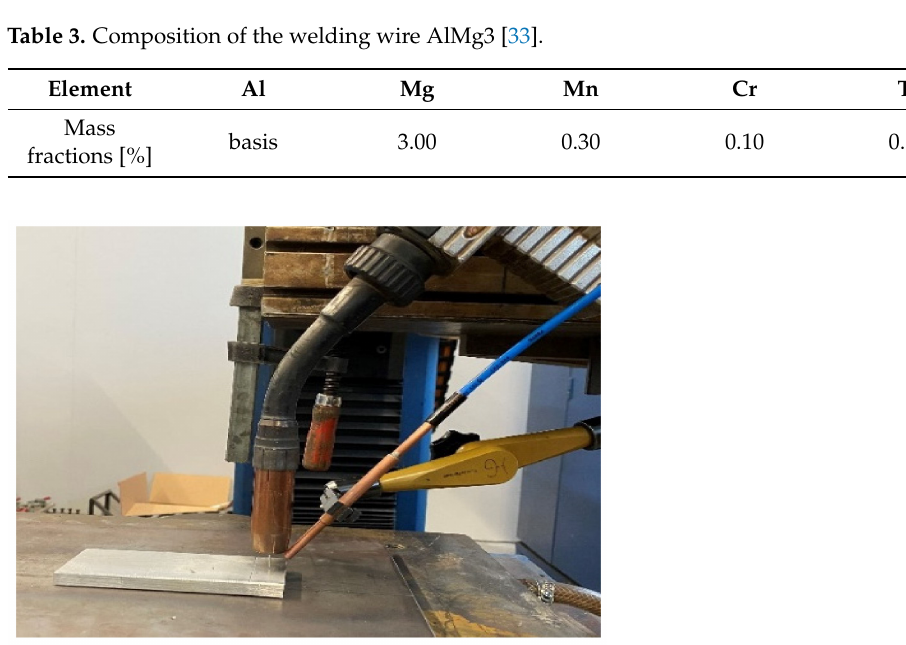
Figure 5. Process setup for the admixture of the magnetic powders in the weld